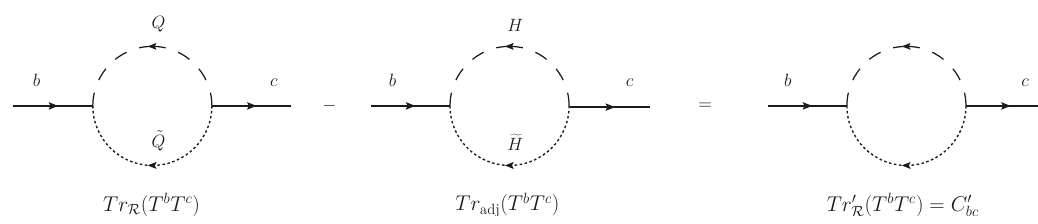
Figure 3 . One-loop correction to (cid:8) propagator in the di(cid:11)erence